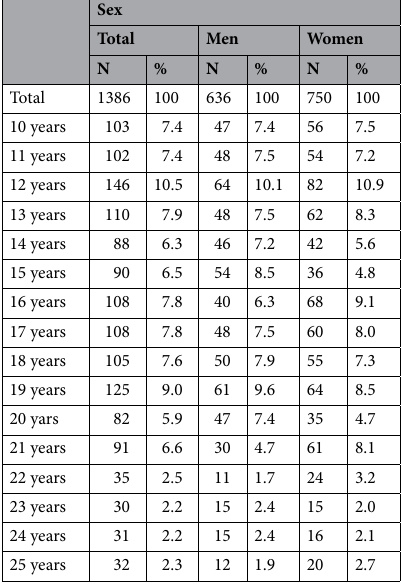
Table 1. Age and sex distribution of the total sample.